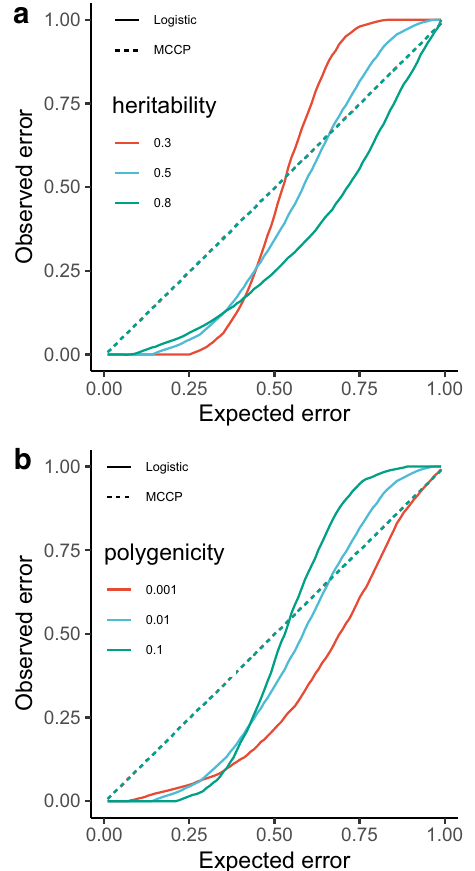
Fig. 2 Calibration plots comparing observed and expected errors from MCCP and the logistic regression model using PRS as a predictor on the simulated data. a Curves for the prevalence of 0.01, polygenicity of 0.01, and heritability (h 2 ) of 0.3, 0.5, and 0.8 are shown. b Curves for the prevalence of 0.01, the heritability of 0.5, and polygenicity of 0.001, 0.01, and 0.1 are shown. The logistic regression is fi tted on the combined proper training and calibration sets and used to make predictions on the test set. The observed error is measured as the proportion of incorrect predictions against true cases or controls status at an expected error rate using the estimated MCCP probability values and probabilities from the logistic regression, respectively. Optimal calibration is shown as dashed gray line that is largely overlapped with MCCP curves. Source data are provided as a Source Data fi